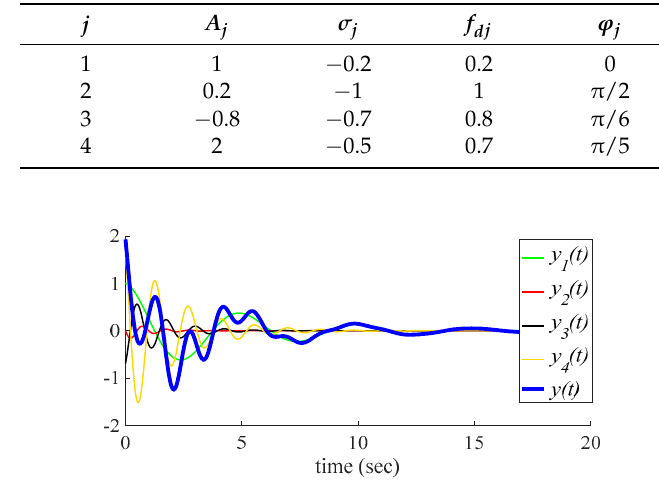
Figure 4. Hypothetical signal of Test Case 1 and its components.